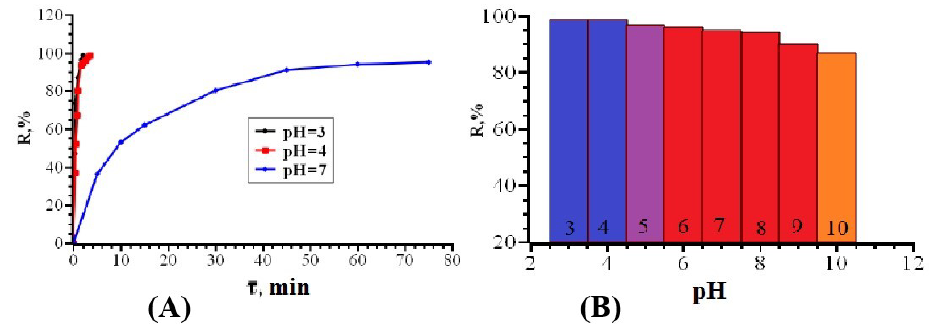
Figure 7. Dependence of the dye removal efficiency on time at different pH ( A ) and on pH ( B ).